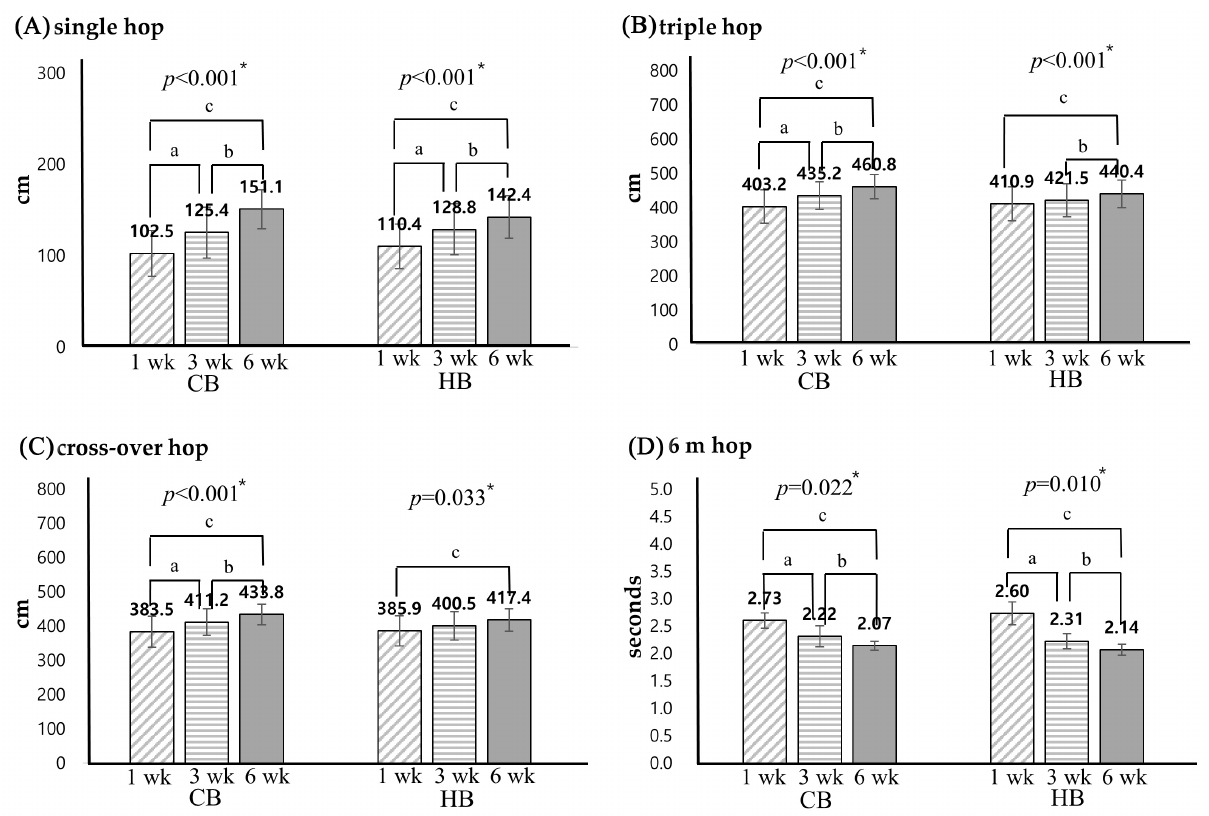
Fig. 4. Hop tests of the CB training and HB training groups. * p < 0.05; a, b, and c mean the significance between measurement weeks (a, 1 week versus 3 weeks; b, 3 weeks versus 6 weeks; c, 1 week versus 6 weeks); CB, center-based; HB, home-based.